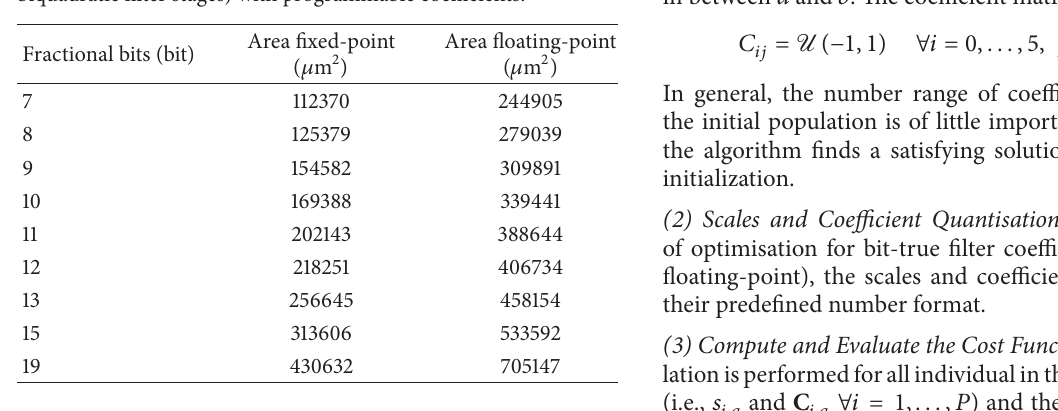
Table 2: Chip area for an IIR filter (order 6, cascade of three biquadratic filter stages) with programmable coefficients.